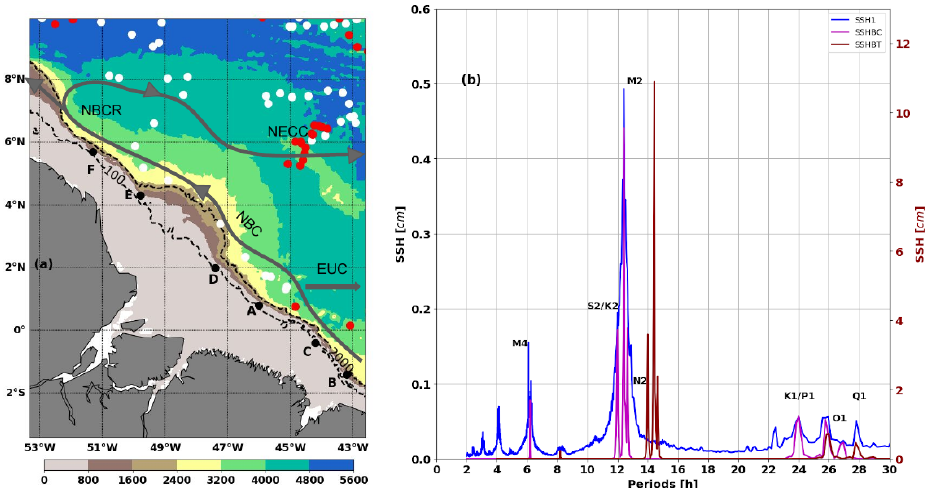
Figure 1. (a) Model bathymetry and Argo profiles locations during MAMJJ (white dot) and ASOND (red dot). Points A, B, C, D, E, and F are internal tide generation sites mentioned in Magalhaes et al. (2016). Dashed blacks contours are 100 and 2000m isobaths. Solid grey contours are NBC, NBCR, and NECC pathways, and EUC position is presented by a grey arrow. (b) SSH frequency spectra based on the 9.5 month (March to December) hourly signal of the coherent barotropic tides (SSHBT, brown), coherent baroclinic tides (SSHBC, magenta), and residual between the full SSH and SSHBT (SSH1, blue). The brown spectrum refers to the right scale and is shifted by 2h for clarity. The spectra are averaged offshore of the 100m